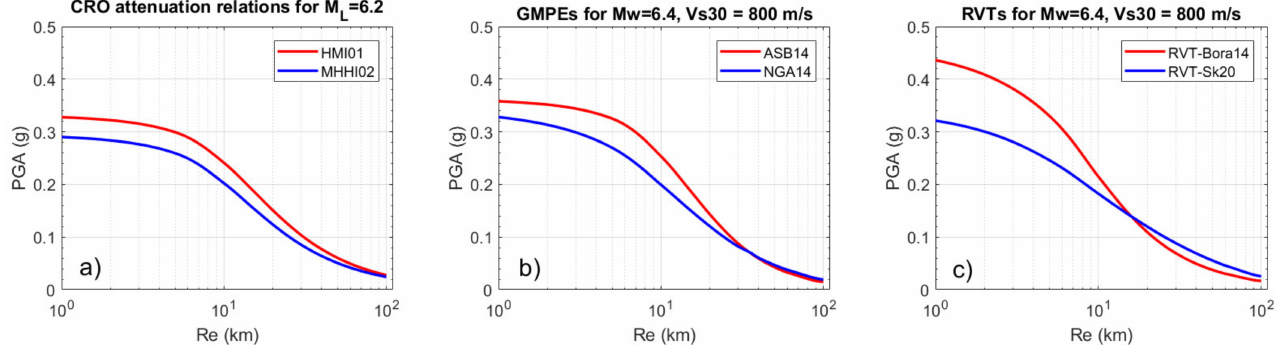
Figure 13. Estimation of the distance scaling PGA for rock ( V S30 = 800 m/s) based on ( a ) available Croatian attenuation relations HMI02 and MHHI02, ( b ) GMPEs from ASB14 that were derived for Pan-European sites and NGA14 (NGA West-2 GMPEs) from BSSA14 and CY14 (with weights of 0.5 for each), and ( c ) Random Vibration Theory models that were derived by Bora14 for the RESORCE-2012 database and RVT-Sk20 for the BSHAP